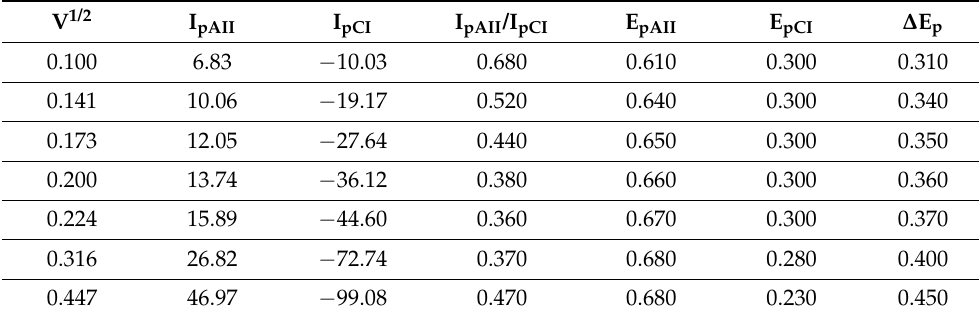
Table 5. Electrochemical data obtained for the Fc/Fc+ redox couple from cyclic voltammograms of the Zn/Fe_CNT paste electrode at different scan